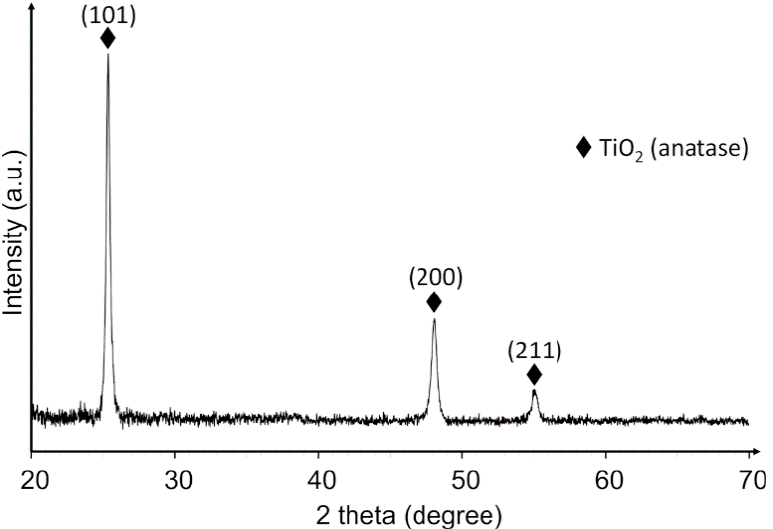
Figure 1. XRD pattern of TiO 2 film deposited on the surface of HDPE beads.